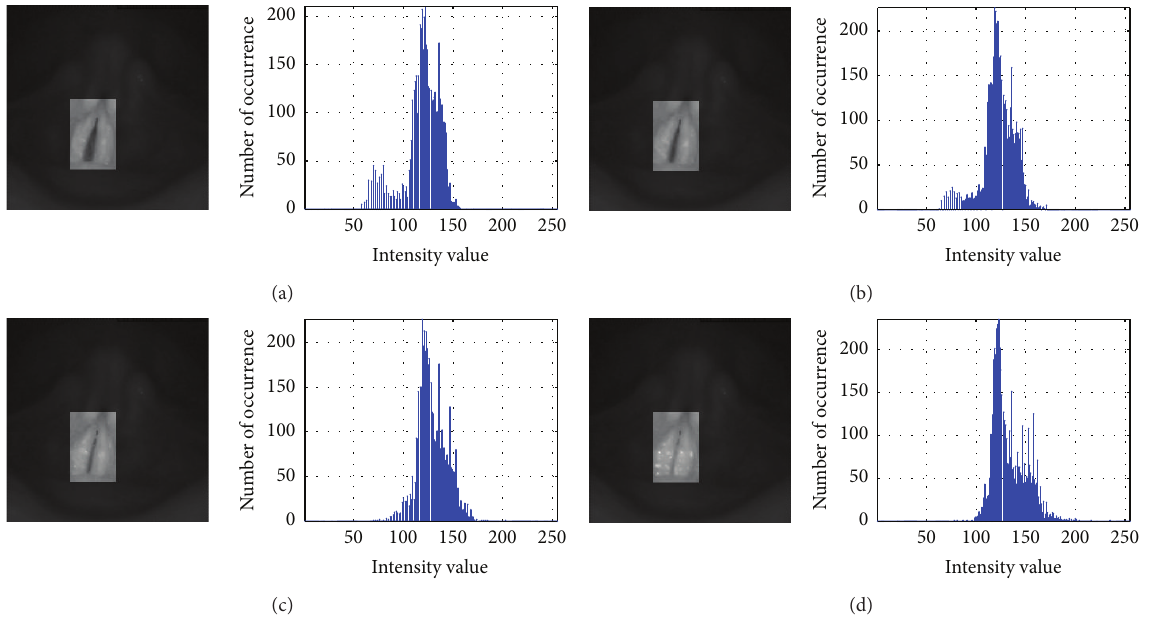
Figure 3: Four snapshots from masked HSV and corresponding